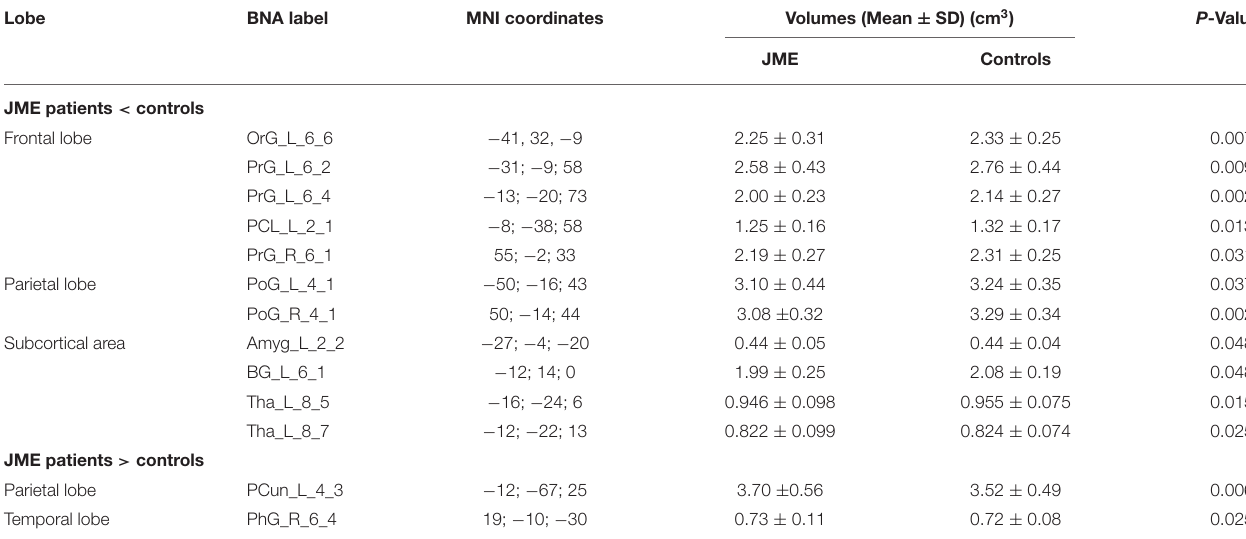
TABLE 2 | Volumetry evaluation of gray matter differences between patients and